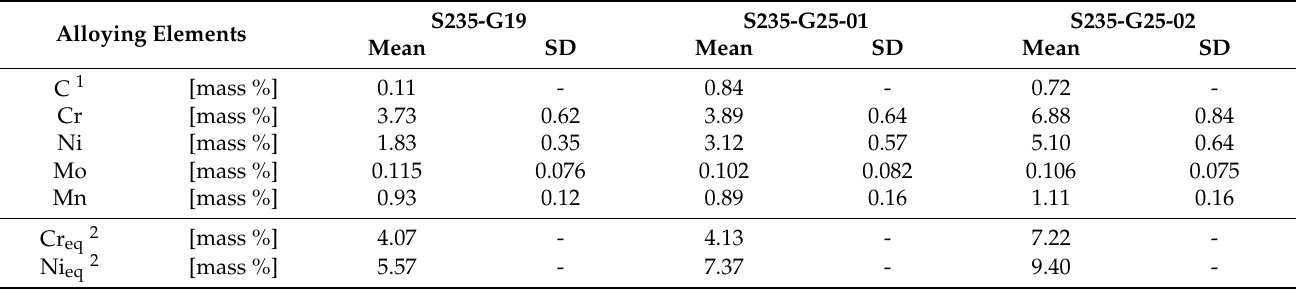
Table 3. Mean chemical composition of the dissimilar welds.